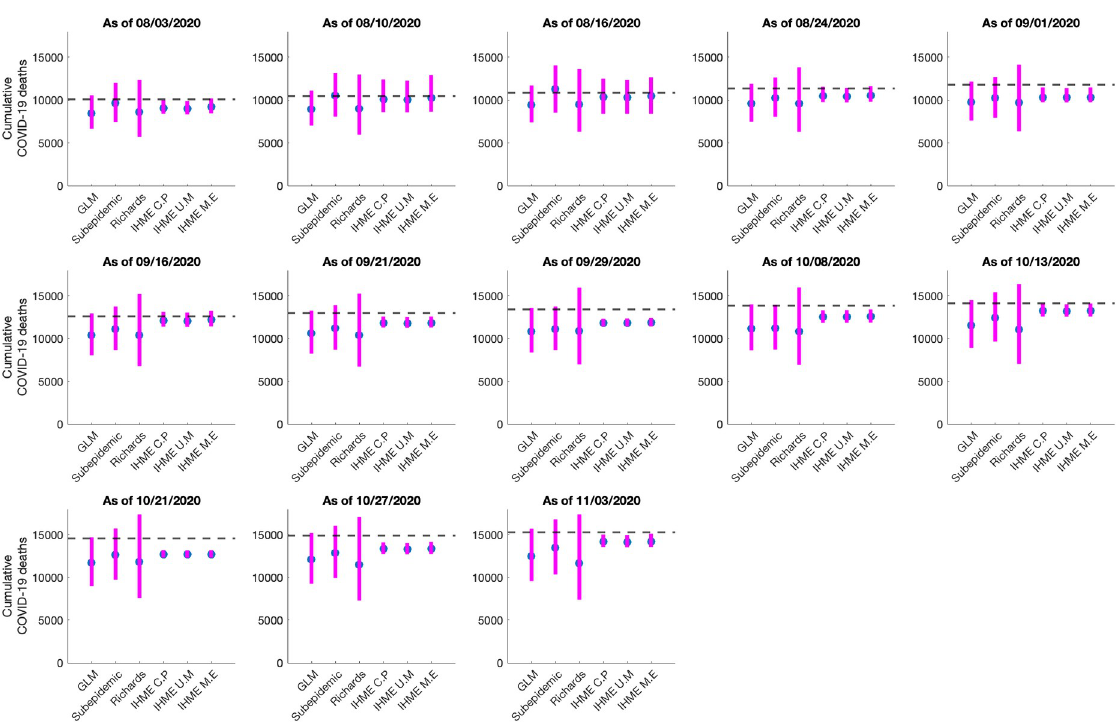
Fig 7. Systematic comparison of six models (GLM, Richards, sub-epidemic model, IHME current projections (IHME C.P), IHME universal masks (IHME U.M) and IHME mandates easing (IHME M.E) to predict the cumulative COVID-19 deaths for the Mexico City in the thirteen sequential forecasts. The blue circles represent the mean deaths, and the magenta vertical line indicates the 95% PI around the mean death count. The horizontal dashed line represents the actual death count reported by that date as published in the November 11, 2020, IHME estimates